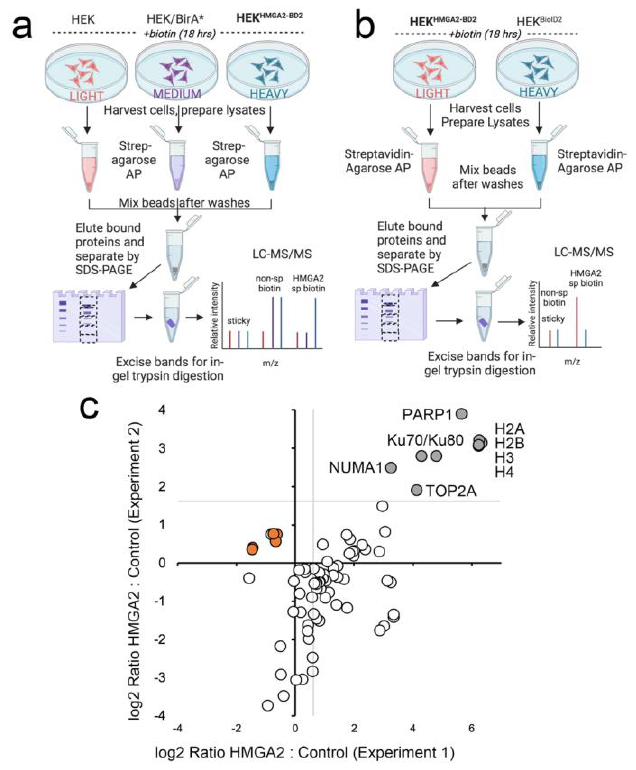
Figure 2. ( a – c ) SILAC BioID2 experiments identify high-confidence interactors for